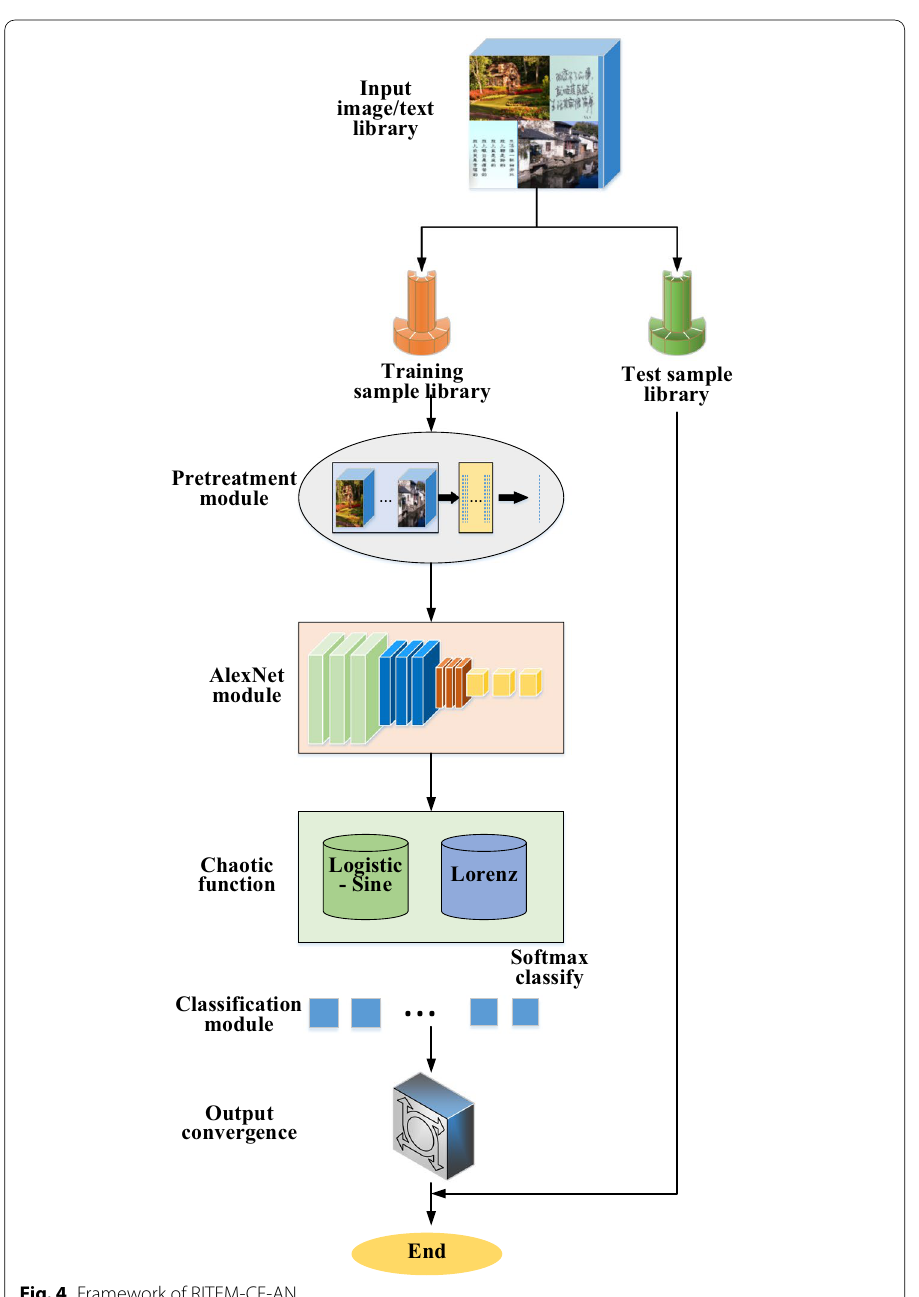
Fig. 4 Framework of